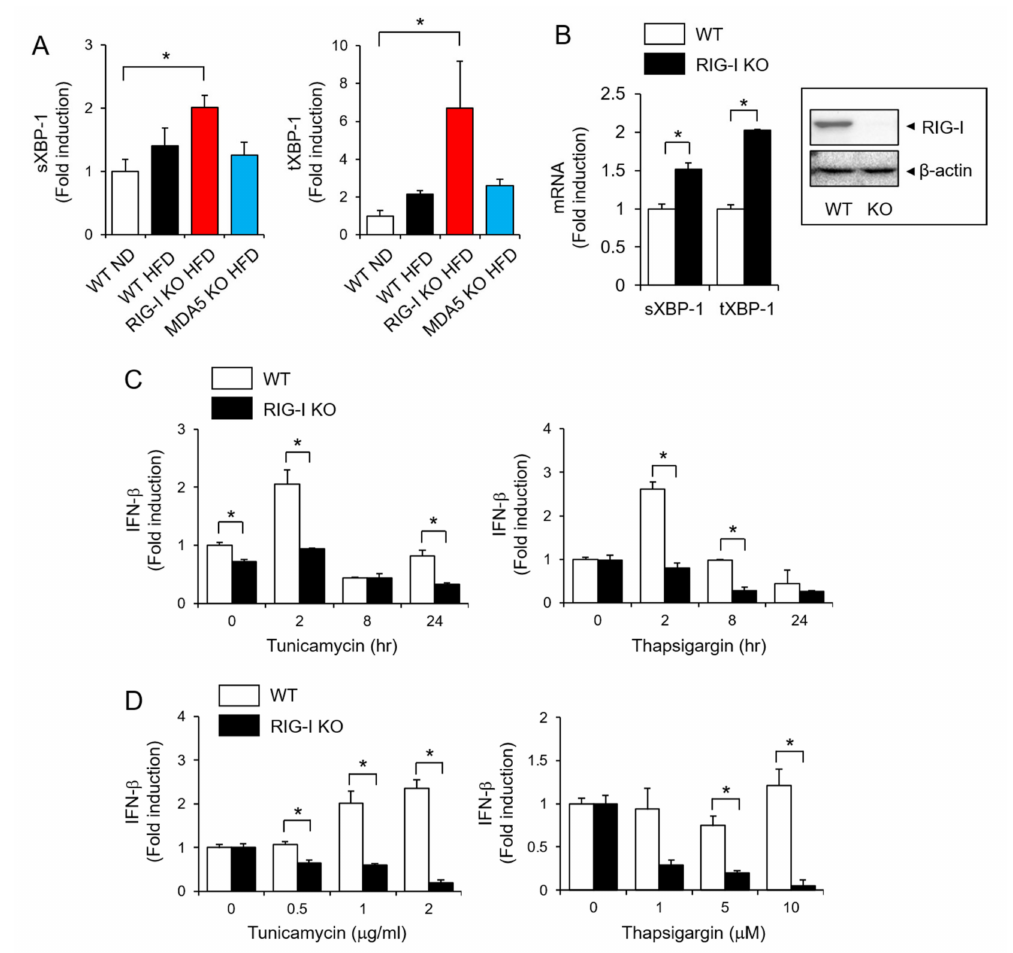
Figure 4. RIG-I is required for IFN- β production in response to ER stress. ( A ) Liver homogenates were prepared from mice after 12 weeks of treatment as described in Figure 1. The mRNA levels of sXBP-1 and tXBP-1 were determined by qRT–PCR. ( B ) Primary mouse hepatocytes isolated from WT or RIG-I KO mice were treated with tunicamycin (1 µ g/mL) for 16 h. The mRNA levels of sXBP-1 and tXBP-1 were determined by qRT–PCR. The protein expression of RIG-I was determined by immunoblotting of the hepatocytes. The original immunoblotting is provided in Figure S3, Supplementary Materials. ( C ) Primary mouse hepatocytes isolated from WT or RIG-I KO mice were treated with tunicamycin (2 µ g/mL) or thapsigargin (10 µ M) for the indicated times. The mRNA levels of IFN- β were determined by qRT–PCR. ( D ) Bone marrow-derived macrophages from WT or RIG-I KO mice were treated with tunicamycin or thapsigargin for 24 h. The mRNA levels of IFN- β were determined by qRT–PCR. The values represent the means ± SEM ( n = 3–5). * p < 0.05. ER stress is accompanied by a viral infection-induced interferon (IFN) response, and ER stress induces type I IFN expression [14]. Treatment with the ER stress inducers tuni-camycin and thapsigargin increased the expression of IFN- β in mouse primary hepato- cytes, but this induction was abolished in RIG-I-deficient hepatocytes (Figure 4C). The role of RIG-I is well known for inducing anti-viral immunity. Therefore, we